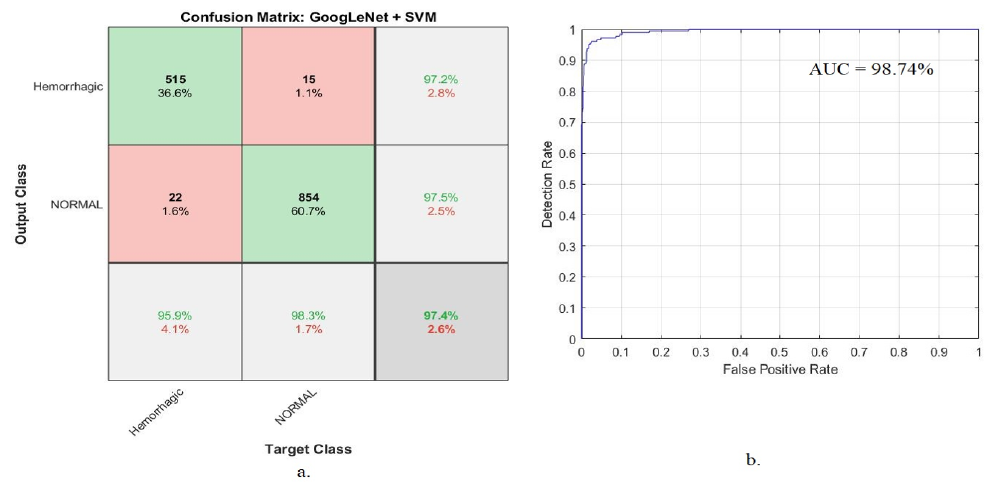
Figure 12. Performance of the GoogleLeNet + SVM model for diagnosing the hemorrhage dataset. ( a ) Confusion matrix. ( b ) AUC.